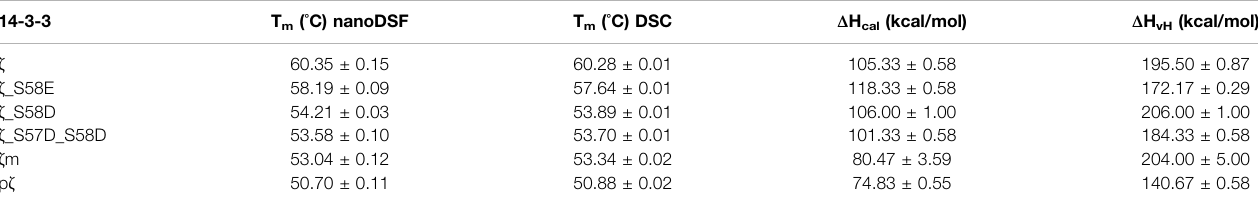
TABLE3| Thermodynamicparametersof14-3-3 ζ variants.Meltingtemperaturesandenthalpiesweremeasuredintriplicates. Δ H vH isexpressedpermoleofthecooperative unit corresponding to the most populated oligomeric state of the 14-3-3 ζ variant, i. e. dimer for ζ and ζ _S58E or monomer for ζ _S58D, ζ _S57D_S58D, ζ m and p ζ